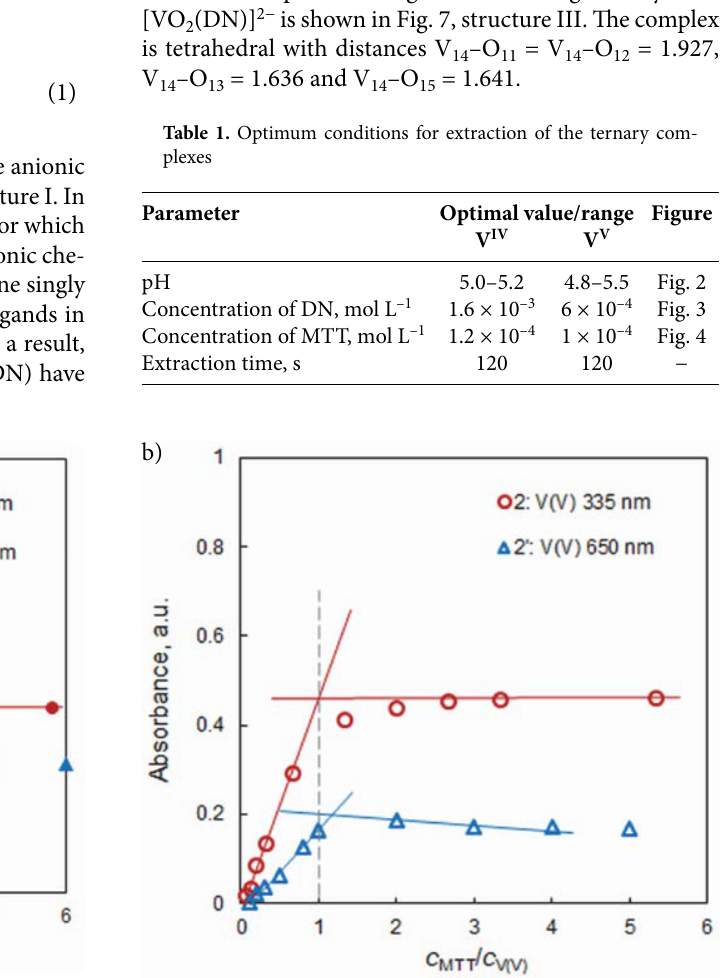
Figure 5. Determination of the DN:V IV (1,1’) and DN:V V (2,2’) mo- lar ratios by the mobile equilibrium method at different wave- lengths. Straight line equations: 1) y = 0.97 x + 4.45; 1’) y = 2.01 x + 6.66; 2) y = 1.00x + 4.41; and 2’) y = 1.09x + 3.64.